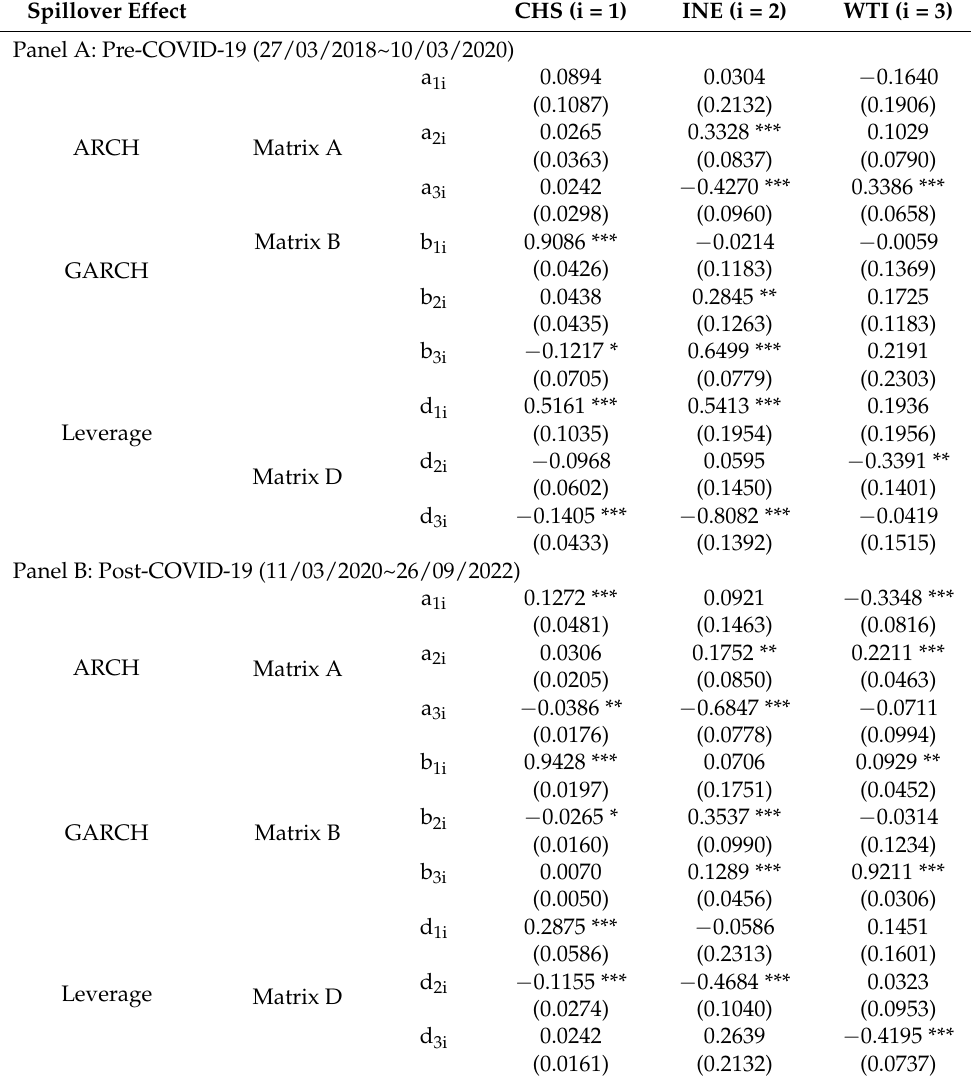
Table 10. Preliminary estimation results of the VAR (1)-BEKK-GARCH (1,1) model for the pre- and post- COVID-19